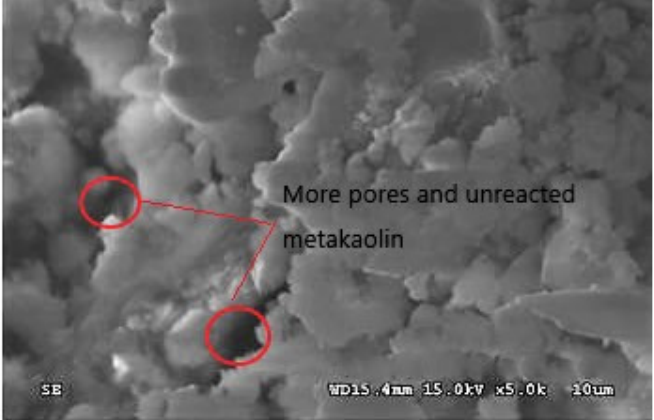
Figure 15. GA1 paste SEM in 5000 k image.